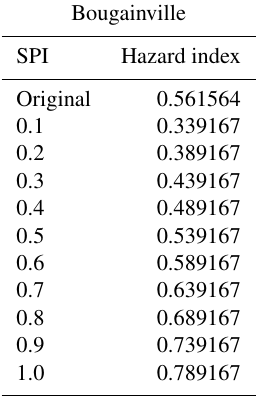
Table A1. An example of the data tables used in the sensitivity anal- ysis. This example is for Bougainville province, analysing the sen- sitivity of the 2015 hazard index to 0.1 incremental changes in the SPI value. Original data tables were formatted in Excel.